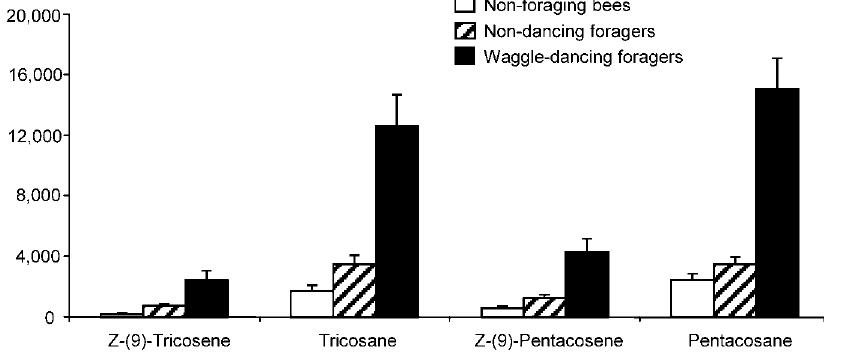
Figure 2. Relative Abundance of Alkanes and Alkenes Relative abundance of Z-(9)-tricosene, tricosane, Z-(9)-pentacosene, and pentacosane sampled from three types of bees. The height of each bar indicates the mean peak area for each compound from GC/MS chromatograms. The relative abundance of compounds is significantly higher for waggle-dancing foragers (black bars) than for either nondancing foragers (hatched bars) or nonforaging bees (white bars, for statistical tests, see text). The relative abundance of compounds for nondancing foragers does not differ from that for nonforaging bees, with the exception of Z-(9)-tricosene. Error bars represent the standard error of the average of six daily mean values, each daily mean comprising a sample of two–three bees of each type. Peak areas represent relative abundance only and thus do not enable comparison among different compounds.